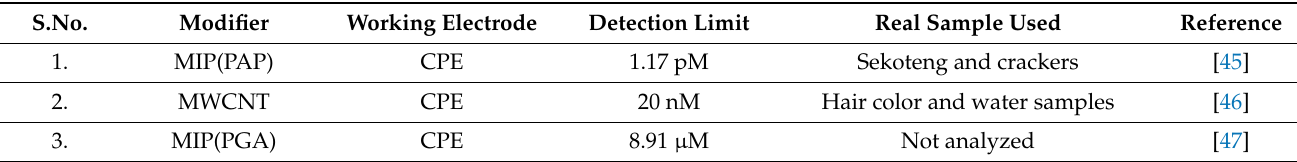
Table 8. Table showing Rhodamine B detection using carbon paste electrodes with different modifiers along with their detection limits.